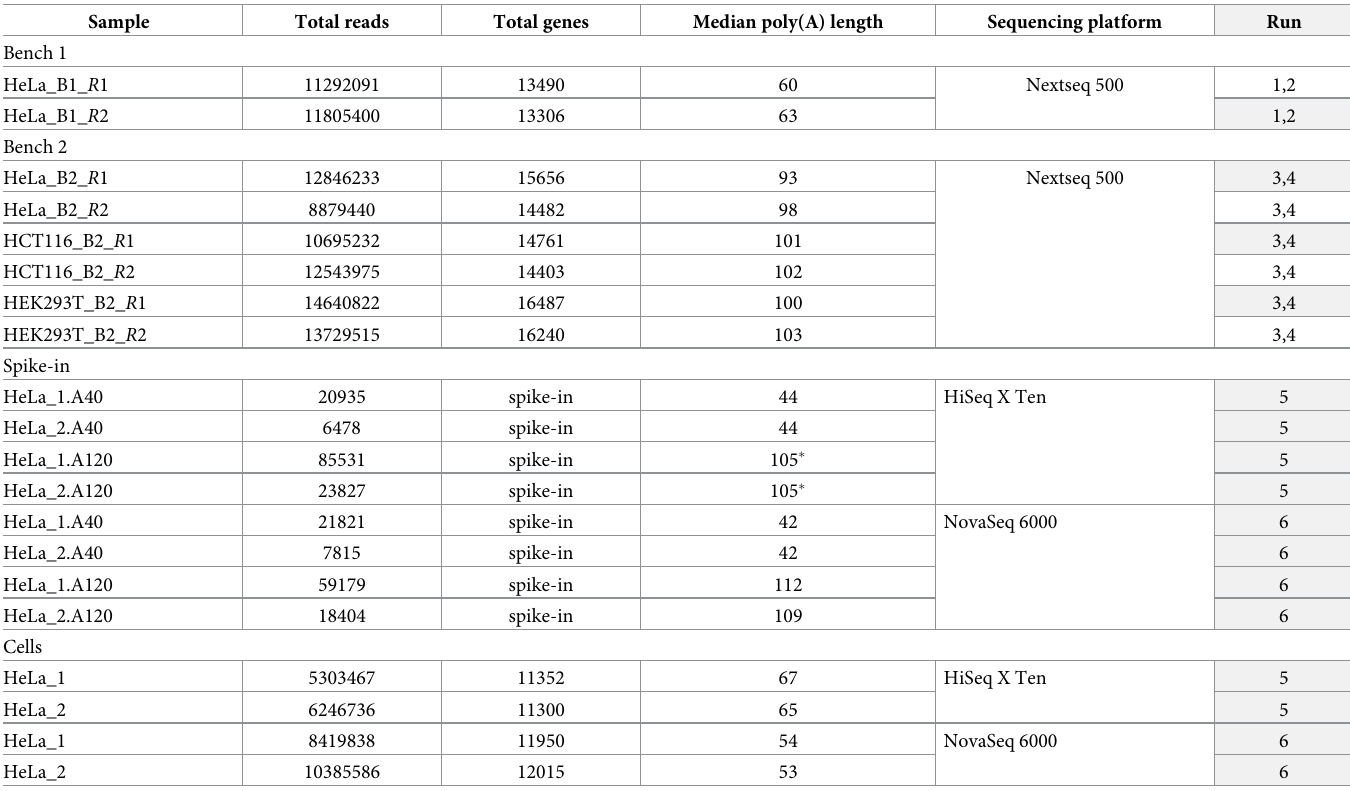
Table 2. Poly(A)-seq profiles of human cells.